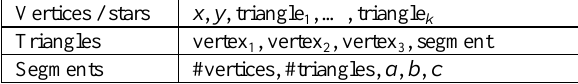
Table 1. The data structure consists of stars, triangles and segments.